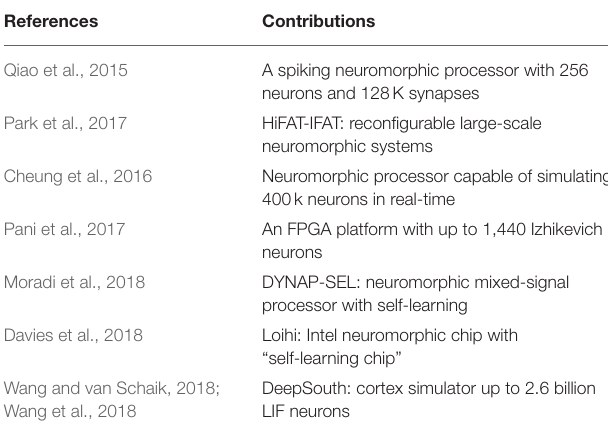
TABLE 1 | Timeline of neuromorphic simulation and